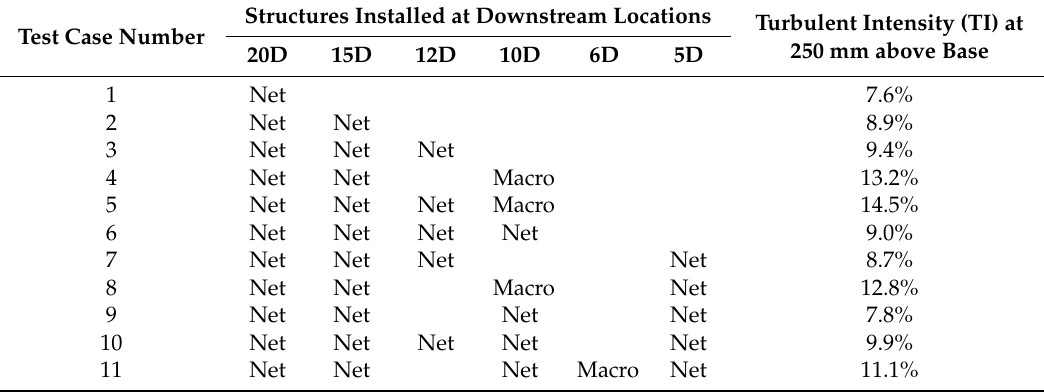
Table 2. Turbulence-generating structures and installation positions during Phase 1 tests.